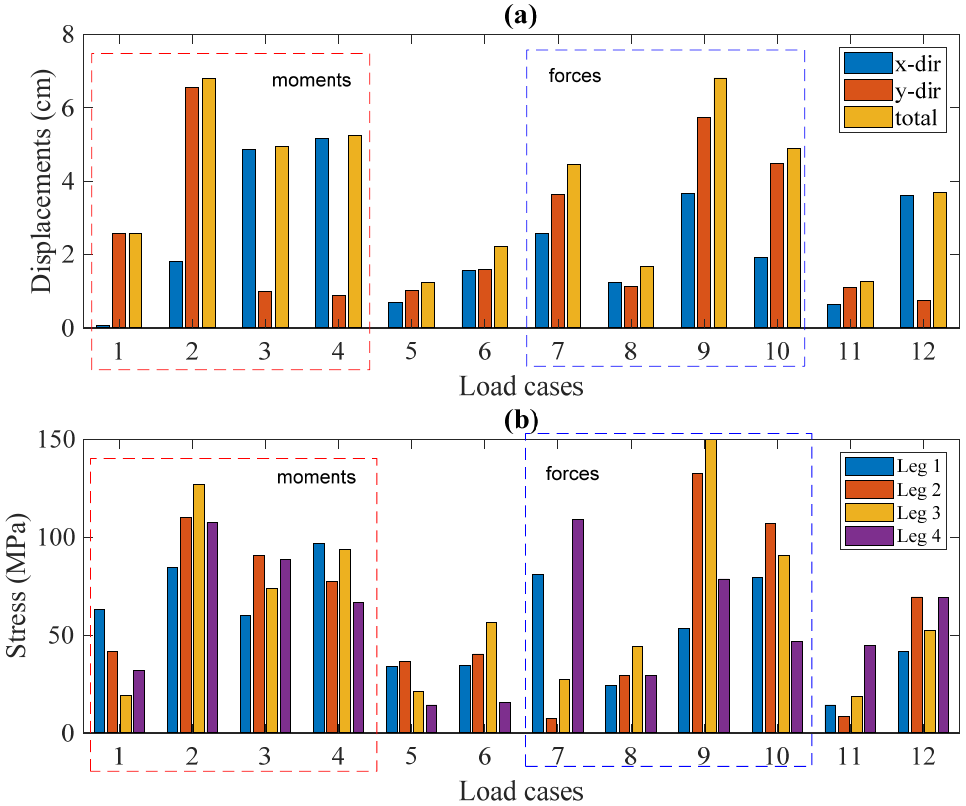
Figure 8. Structural responses under DLC loads: ( a ) displacements at IP (cm); ( b ) stresses at lower jacket legs (MPa).